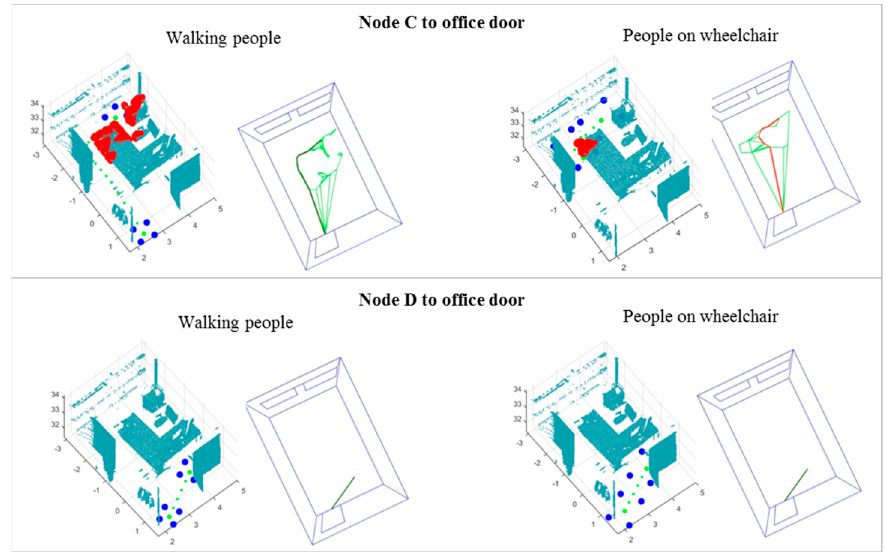
Figure 15. The resulting paths for “Node C to office door” and “Node D to office door” are represented (units in